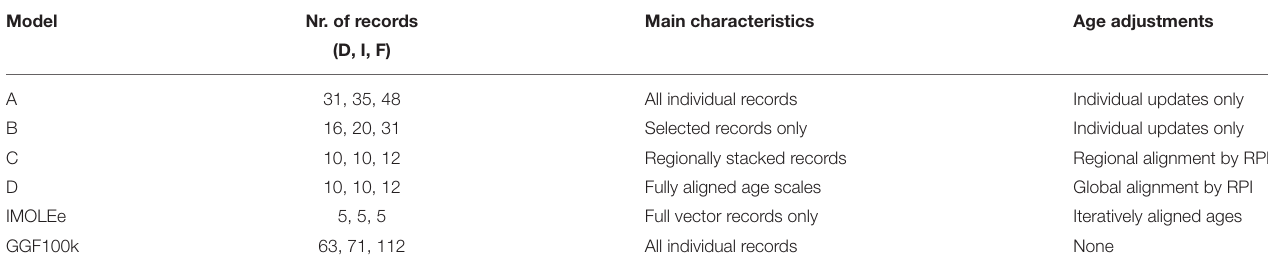
TABLE 1 | Characteristics of sediment data sets underlying the